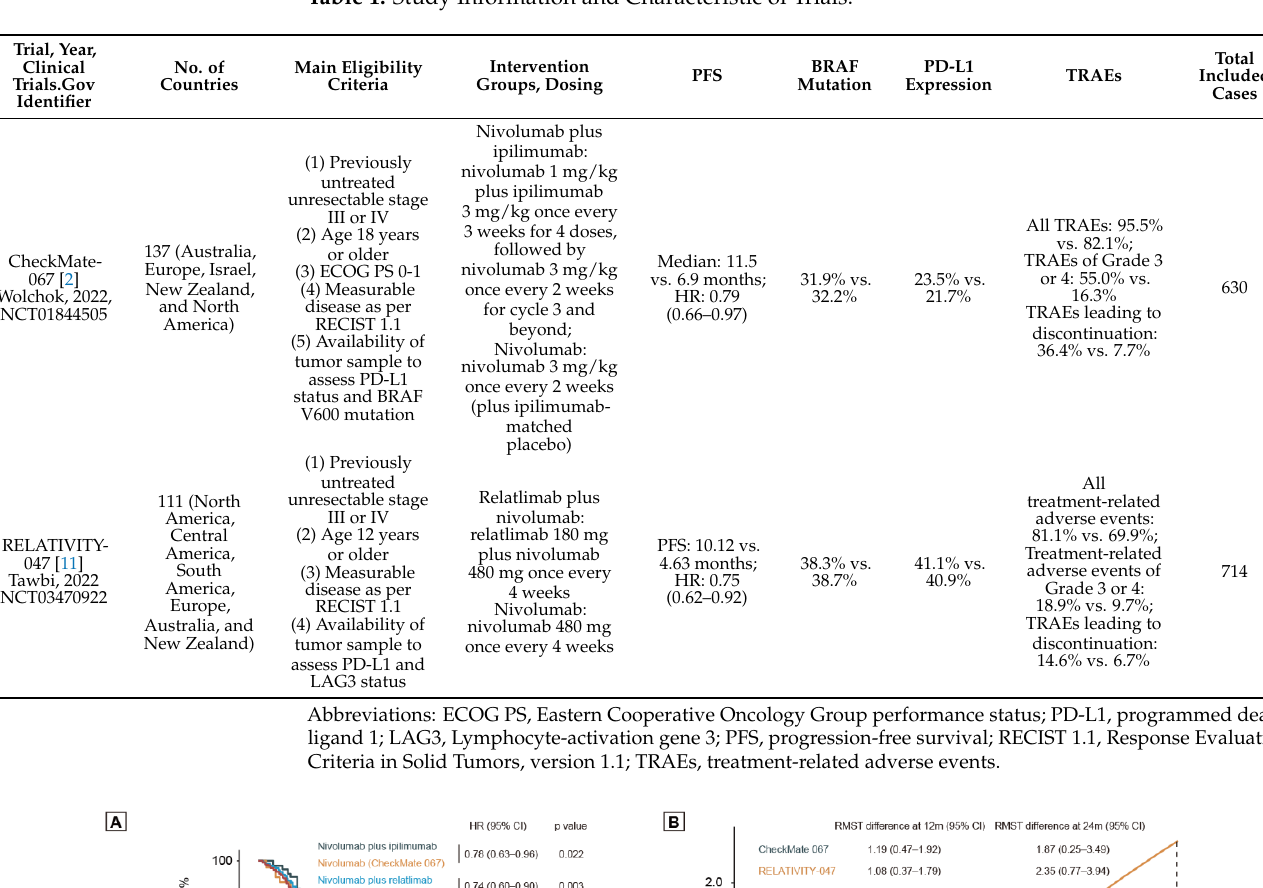
Figure 3. Bayesian Hierarchical Survival Model. ( A ) The time-varying HR is based on the Bayesian hierarchical model. The dotted line indicates that the upper limit of the confidence interval of esti- mated HR is higher than 1. ( B ) Posterior means of PFS of the treatment arms of CheckMate-067 and RELATIVITY-047 trials. Abbreviations: HR, hazard ratios; CI, confidence interval; RMST, restricted mean survival time.